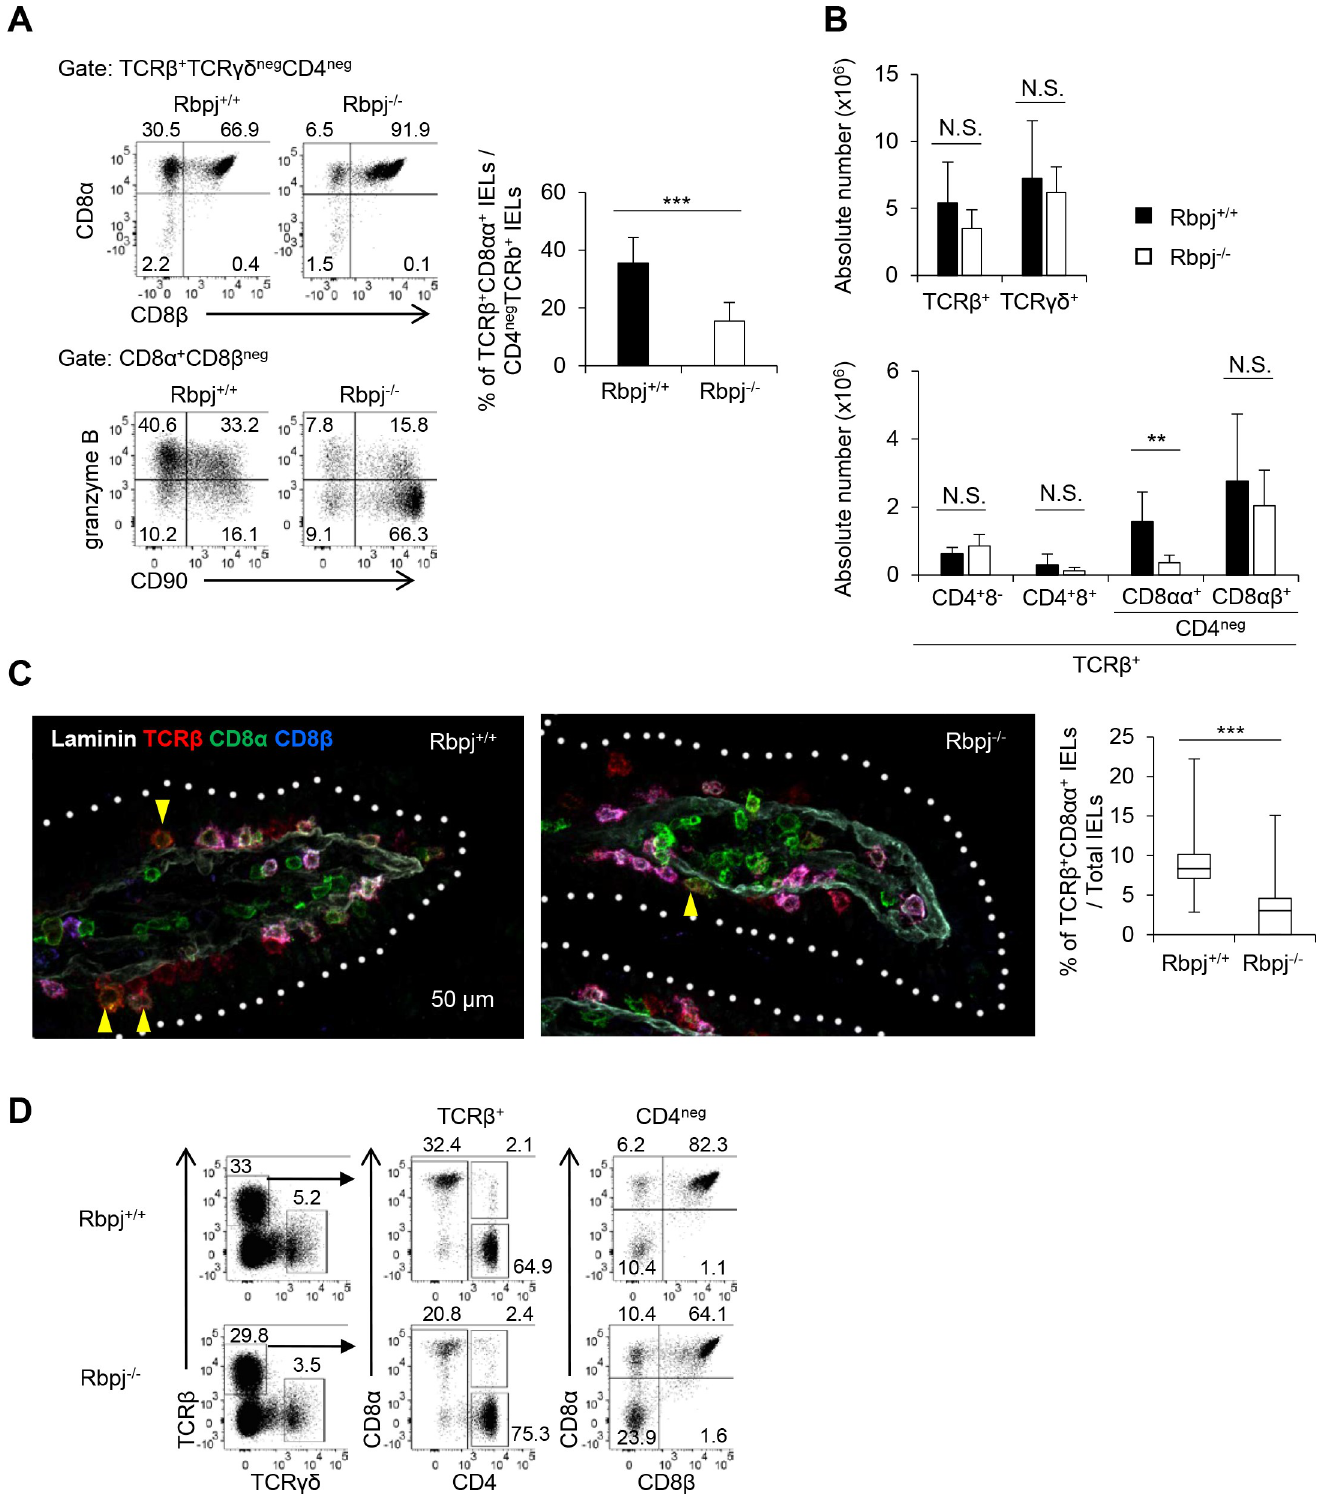
Fig 1. Rbpj in T cells is required for TCR αβ + CD8 αα + IELs. The (A) frequency and (B) total cell number of IELs or (A) CD90 and granzyme B expression on TCR αβ + CD8 αα + IELs in Rbpj +/+ and Rbpj − / − mice at the age of 8 wk were evaluated by flow cytometry. The data of (A) and (B) are representative of four independent experiments. The data are shown as mean ± S.D., and �� or ��� indicates p < 0.01 or p < 0.001, respectively ( n = 5). (C) Sections of small intestine from